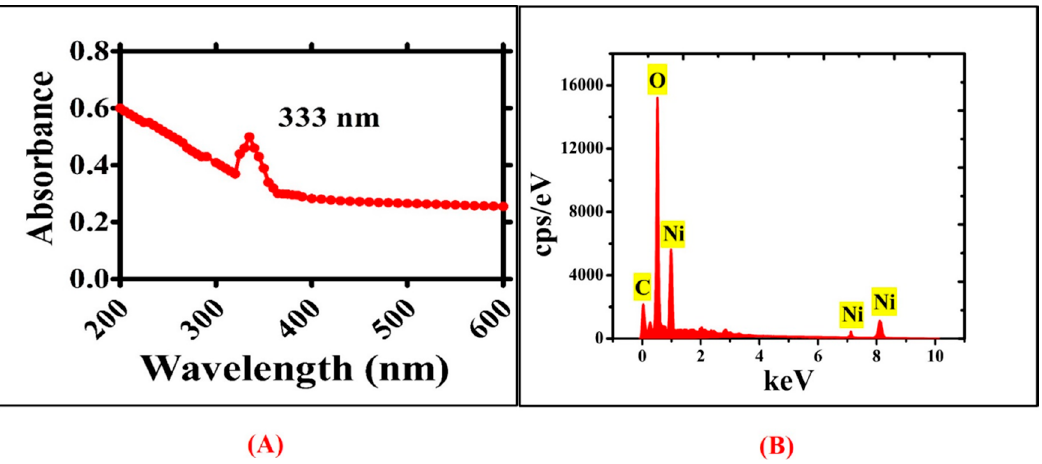
Figure 2. UV visible spectra and EDS analysis for RT. NiONPs ( A ) UV visible spectra for NiONPs ( B ) Elemental composition of NiONPs using EDS analysis.